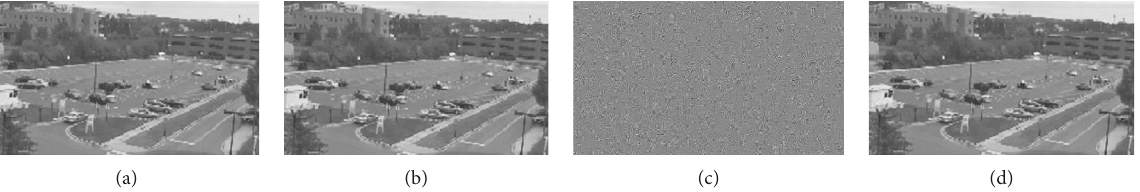
Figure 4: Sample results of the proposed framework: keyframe (a), compressed keyframe without encryption step (b), encrypted keyframe (c), and the decrypted keyframe (d).